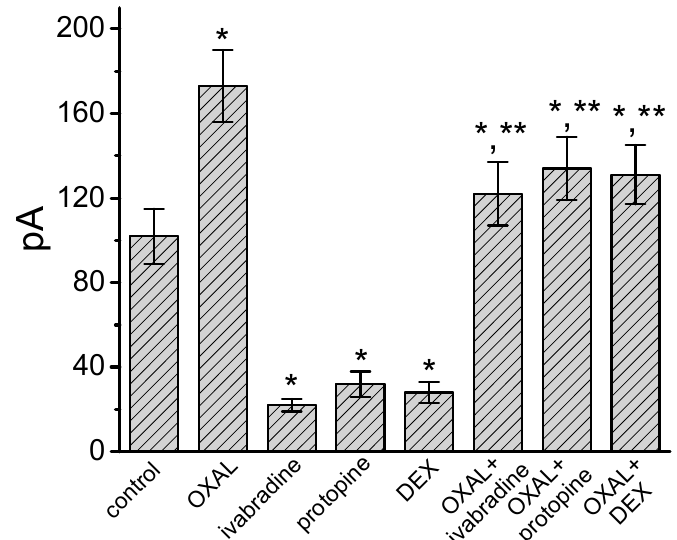
Figure 2. The e ff ects of OXAL (3 µ M), ivabradine (3 µ M), protopine (3 µ M), dexmedetomidine (DEX, 3 Figure 2. The effects of OXAL (3 μ M), ivabradine (3 μ M), protopine (3 μ M), dexmedetomidine (DEX, µ M), OXAL (3 µ M) plus ivabradine (3 µ M), OXAL (3 µ M) plus protopine (10 µ M), and OXAL 3 μ M), OXAL (3 μ M) plus ivabradine (3 μ M), OXAL (3 μ M) plus protopine (10 μ M), and OXAL plus